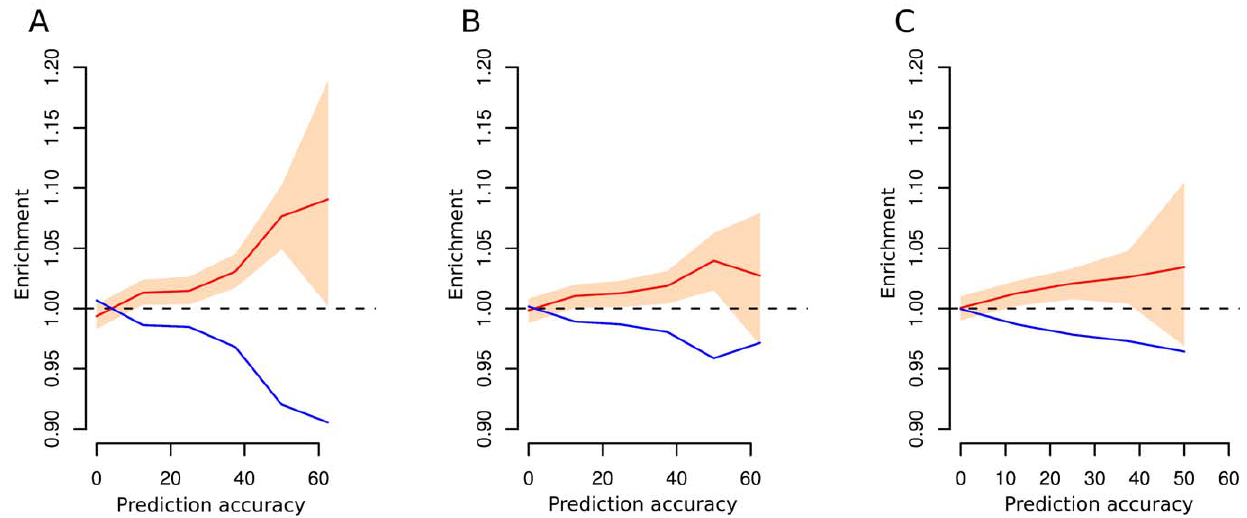
Figure 2. Enrichment of SNPs for different values of prediction accuracy computed on distinct models. Enrichment of genic (red line) versus intergenic SNPs (blue line) for different values of prediction accuracy computed on models comprising only pathogen diversity (panel A), subsistence strategies (panel B) and climate conditions (panel C) separately. Peach region denotes 90 th confidence interval computed with 1,000 bootstrap resamplings on blocks of contiguous SNPs.